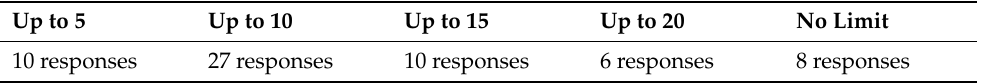
Table 10. Participants’ responses concerning the number of words for the